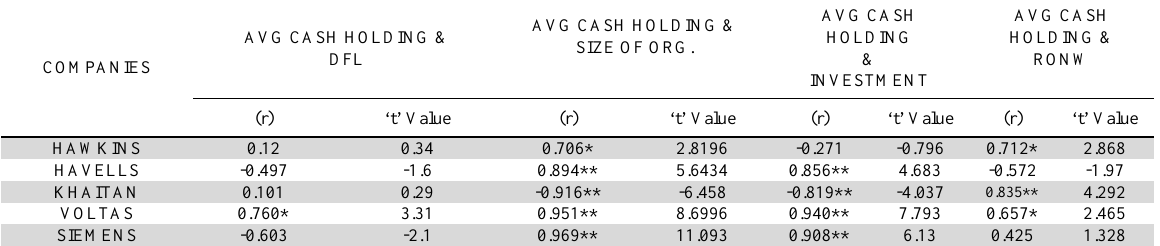
Karl Pearson’s Simple Correlation Analysis between AVG Cash Holding and DFL, Size of Org., Investment and RONW of the Selected Companies of Consumer Durable